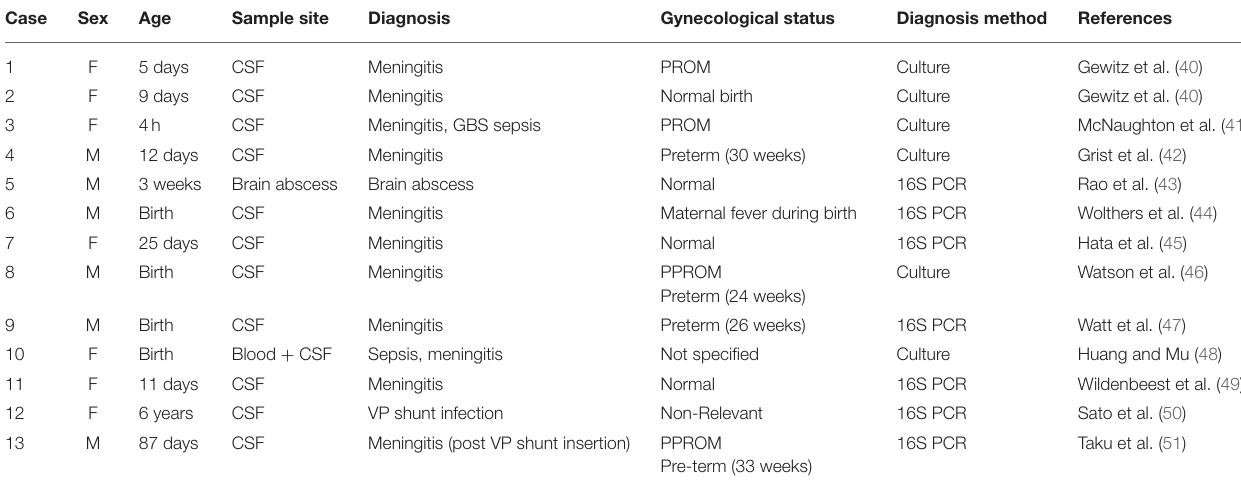
TABLE 2 | Pediatric cases of M. hominis CNS